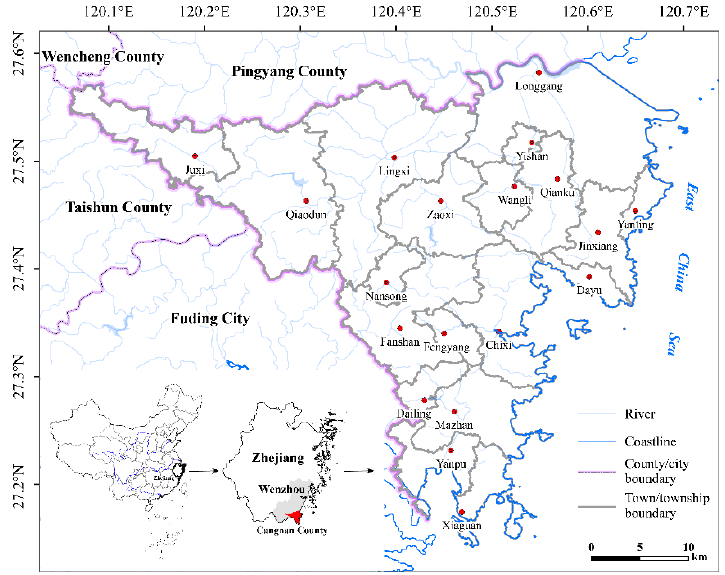
Figure 1. Study area, Cangnan County, located in Zhejiang Province, East China.